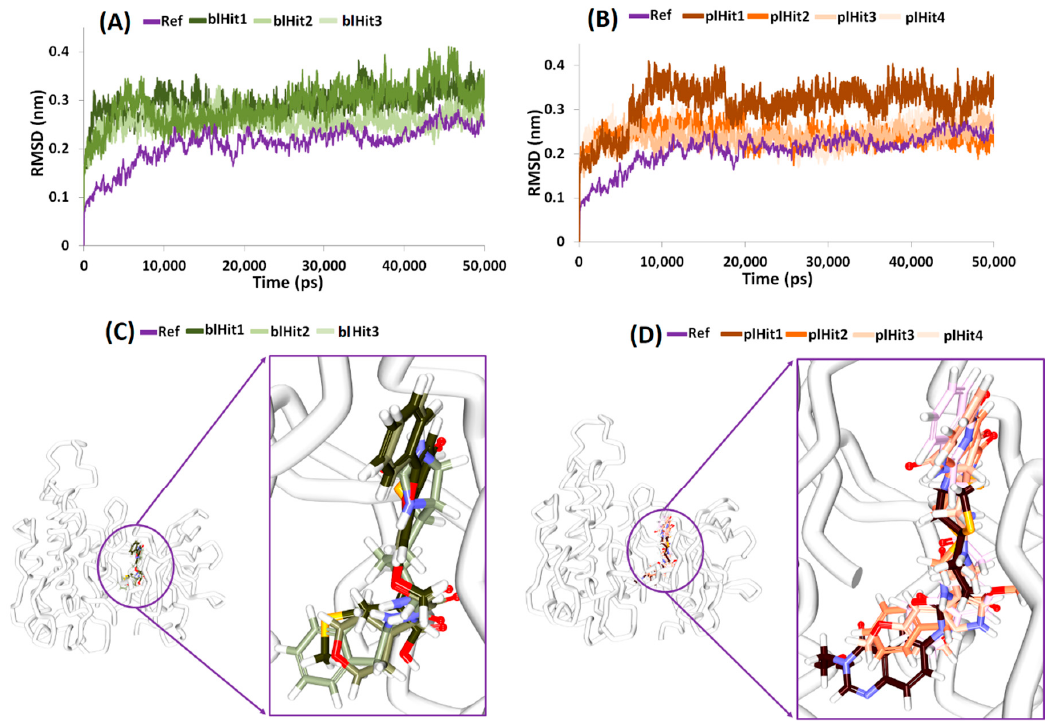
Figure 4. Results obtained through molecular dynamics (MD) studies. ( A ) Root mean square deviation (RMSD) of the protein-hit compounds from the Natural-Product-Based Library (NPBL) database. ( B ) RMSD of the protein-hit compounds from the Natural-Product-Like Library (NPLL) database. ( C ) Binding mode analysis of compounds from NPBL database. ( D ) Binding mode analysis of compounds from NPLL database.